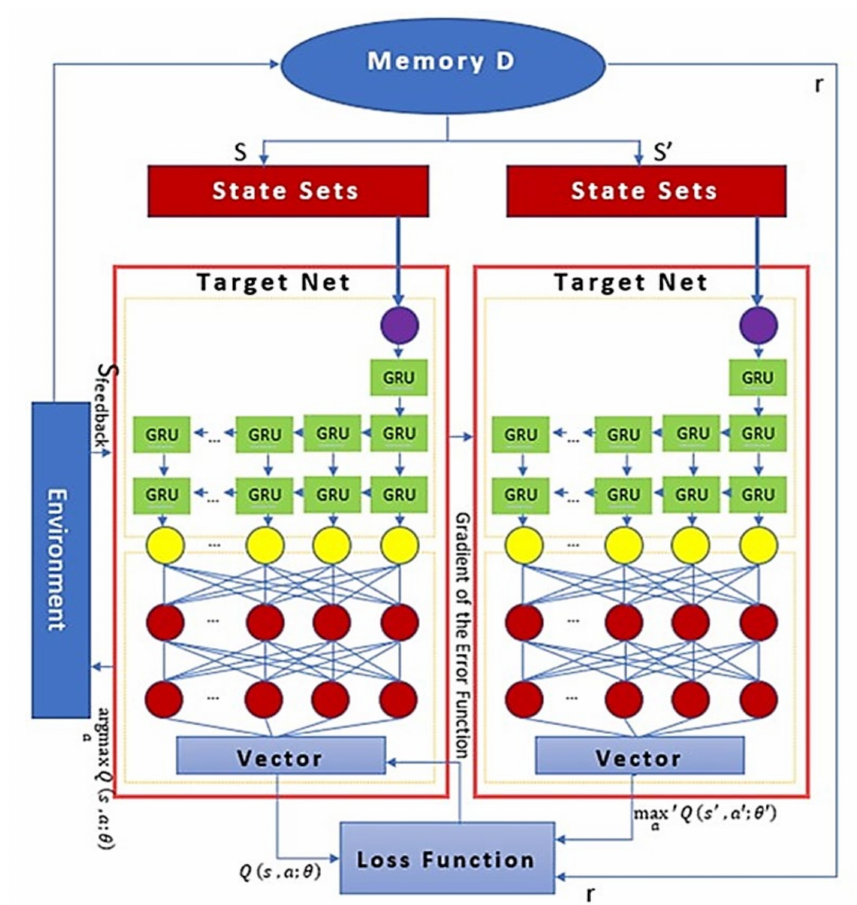
Figure 11. Proposed framework based on integration of Gated Recurrent Unit (GRU) with Double Deep Q-learning Network